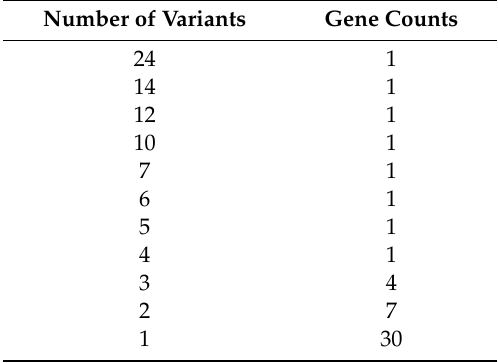
Table 5. Distribution of genes with different numbers of variants in heterozygous sites in the genome of B. naardenensis CBS 7540.